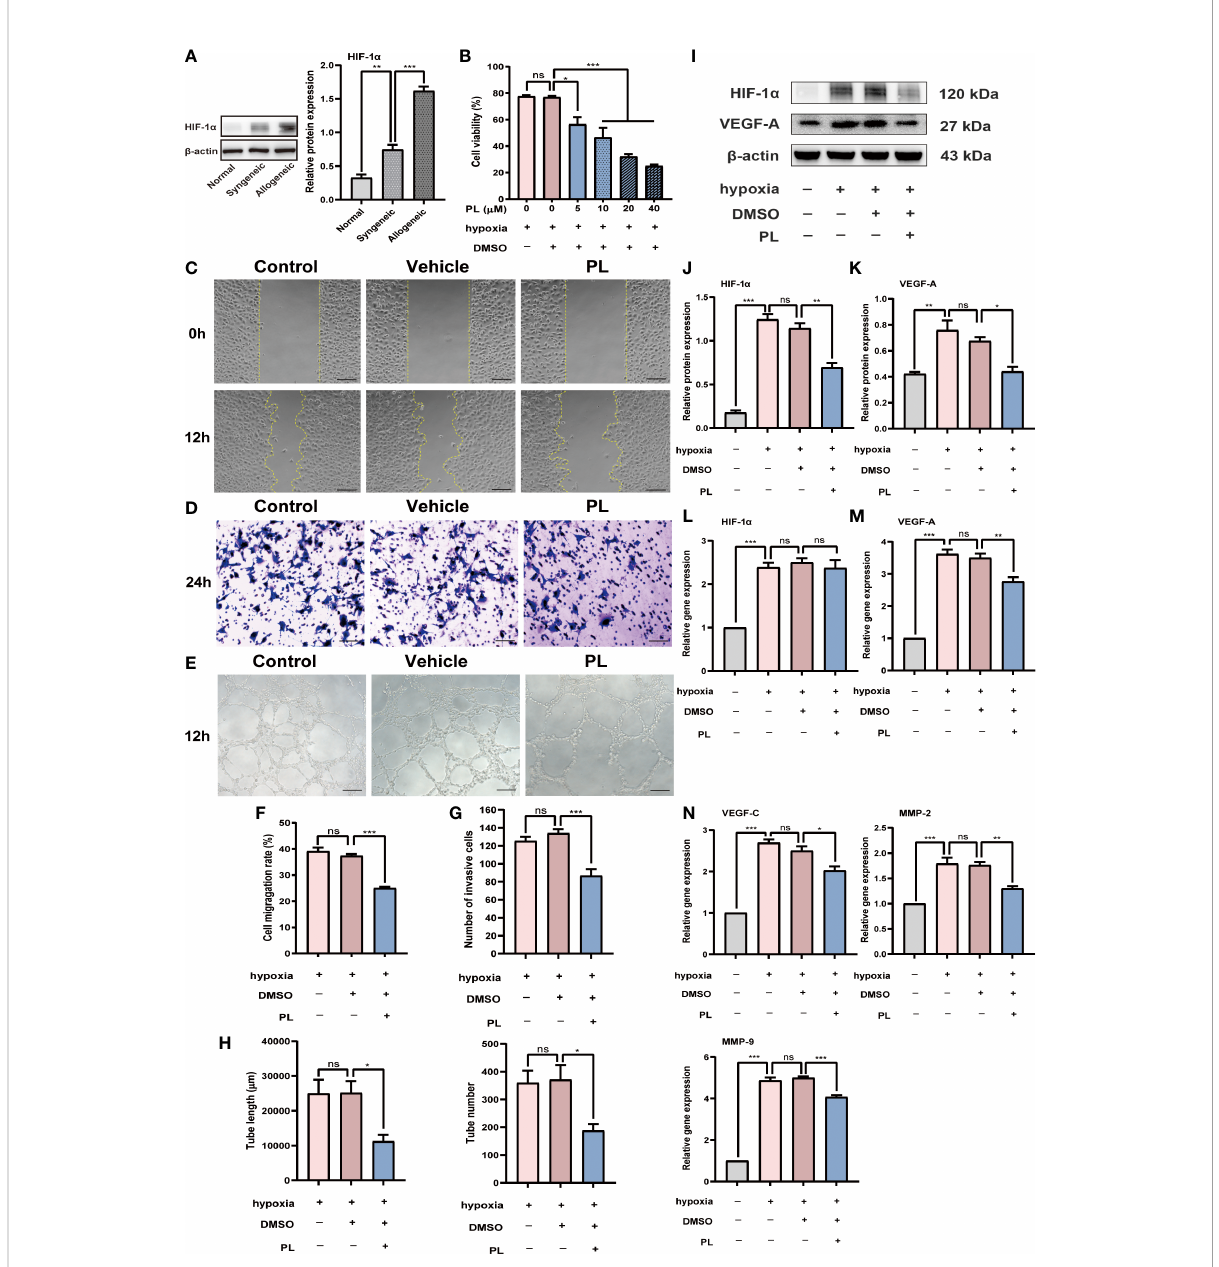
FIGURE 4 PL inhibited hypoxia-induced angiogenesis in HUVECs. (A) Representative Western blot images and semiquantitative analysis of the level of HIF- 1 a in the corneal grafts from normal, syngeneic, and allogeneic groups (n = 6/group). (B) HUVECs were incubated in the hypoxic incubator with nothing, vehicle (0.1% DMSO) or PL (5 m M, 10 m M, 20 m M or 40 m M). The effect of different concentrations of PL on HUVECs proliferation was assessed by a CCK8 assay. (C) Representative images of wound healing assay were taken at 0 h after scratch-wounding and 12 hours after PL treatment (5 m M). scale bar 100 µm. (D) Representative images of invasion assay were taken at 24 hours after PL treatment (5 m M). scale bar 50 µm. (E) Representative images of tube formation assay were taken at 12 hours after PL treatment (5 m M). scale bar 100 µm. (F-H) Quantitative analysis of wound healing, transwell invasion and tube formation assay in different groups. The tube length and tube number were assessed in tube formation assay. (I-M) HUVECs were incubated under normoxia or hypoxia with or without PL (5 m M). Hif-1 a and VEGF-A protein and mRNA expression were measured by western blot and qRT-PCR. (N) The mRNA expression levels of VEGF-C, MMP-2 and MMP-9 were analyzed by qRT-PCR. Ns P > 0.05, *P < 0.05, **P < 0.01, ***P <